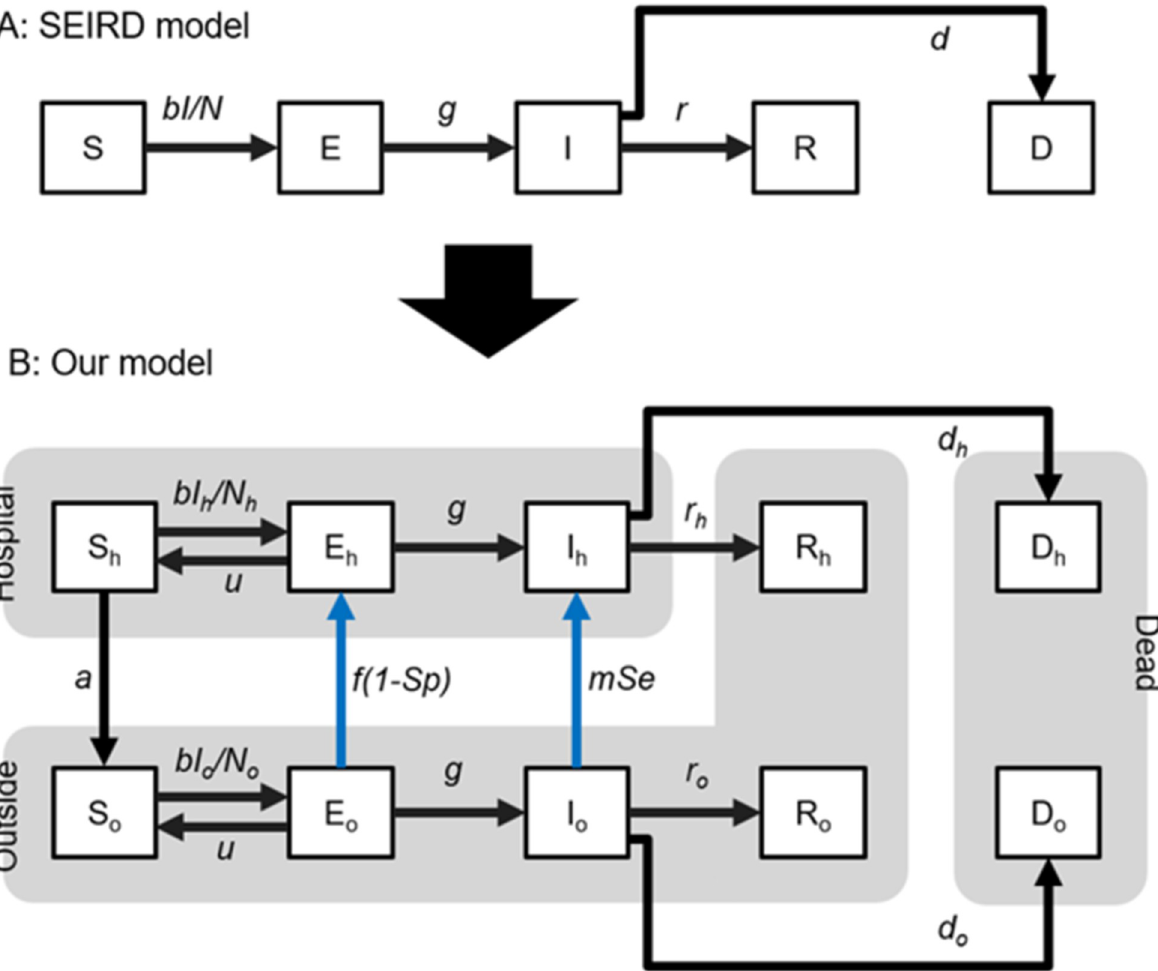
Fig 1. Schematic of the classical SEIRD and testing-SEIRD models. (A) Classical SEIRD model: An infectious population “I” exposes a susceptible population “S” at a rate inversely proportional to the infectious population. The exposed population “E” becomes infectious “I.” The infected population finally recovers “R” or is dead “D.” (B) Testing-SEIRD model: The population is divided into two subpopulations; inside and outside the hospital. The exposed “E o ” and the infectious population outside “I o ” are hospitalized if evaluated as positive after testing. A susceptible population “S h ” remains at the hospitals. The black lines indicate population transitions, regardless of the capacity effect. The blue lines indicate population transition, considering the capacity effect. Transitions from “E o ” to “E h ” and “I o ” to “I h ” are categorized as hospitalized.